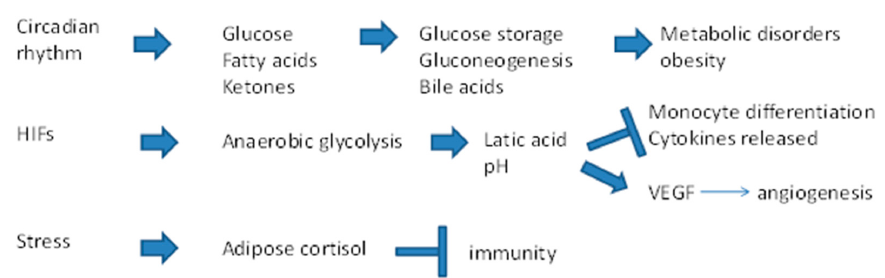
Figure 5. Possible causes of liver damage due to circadian rhythm alterations, hypoxia and psychological stress. Disruption of the circadian rhythm is a risk factor for obesity, metabolic disorders and